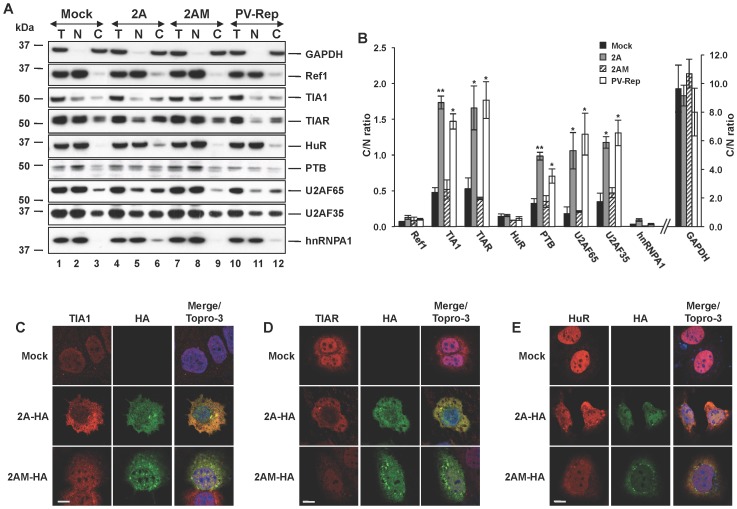
Expression of 2Apro provokes nuclear-cytoplasmic redistribution of splicing factors.(A) Huh7-T7 cells were transfected with pTM1-2A, pTM1-2AM, PV-Rep or empty plasmid. Subcellular distributions of the indicated proteins were analyzed by immunoblot using the respective antibodies. T refers to total, N refers to nuclear, and C refers to cytoplasmic fractions. GAPDH and Ref1 were used as controls for cytoplasmic and nuclear location respectively. (B) The densitometry of the bands was used to calculate the cytoplasm/nucleus ratio for each protein shown. Data are mean ± s.d. (n = 3; *P<0.05; **P<0.01 by Student’s t-test). (C-E) Immunofluorescence staining of TIA1, TIAR and HuR proteins in Huh-7-T7 cells. Cells transfected as in (A) were immunolabelled with the indicated antibodies. Merge/Topro-3 refers to simultaneous visualization of images. Scale bars: 10 µm.